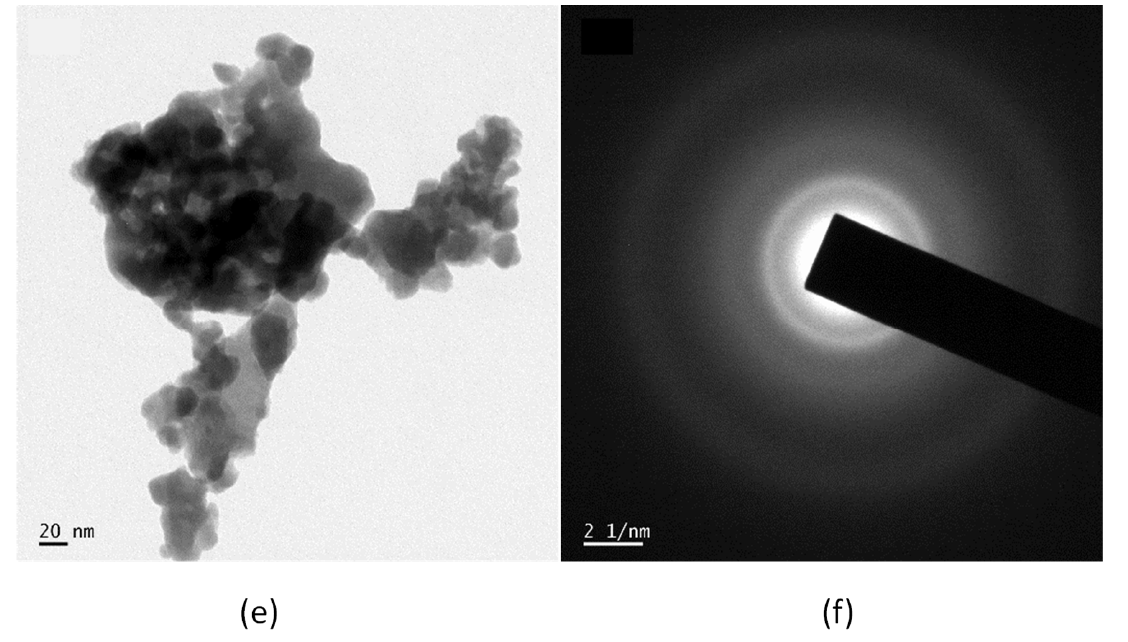
Figure 1. ( a ) FTIR of Bi 2 O 3 NPs, ( b ) XRD pattern of Bi 2 O 3 NPs, ( c ) UV-Vis DRS spectrum of Bi 2 O 3 NPs, ( d ) SEM images of Bi 2 O 3 NPs under different magnification, ( e ) TEM images of Bi 2 O 3 NP and ( f ) SAED patterns of Bi 2 O 3 NP.